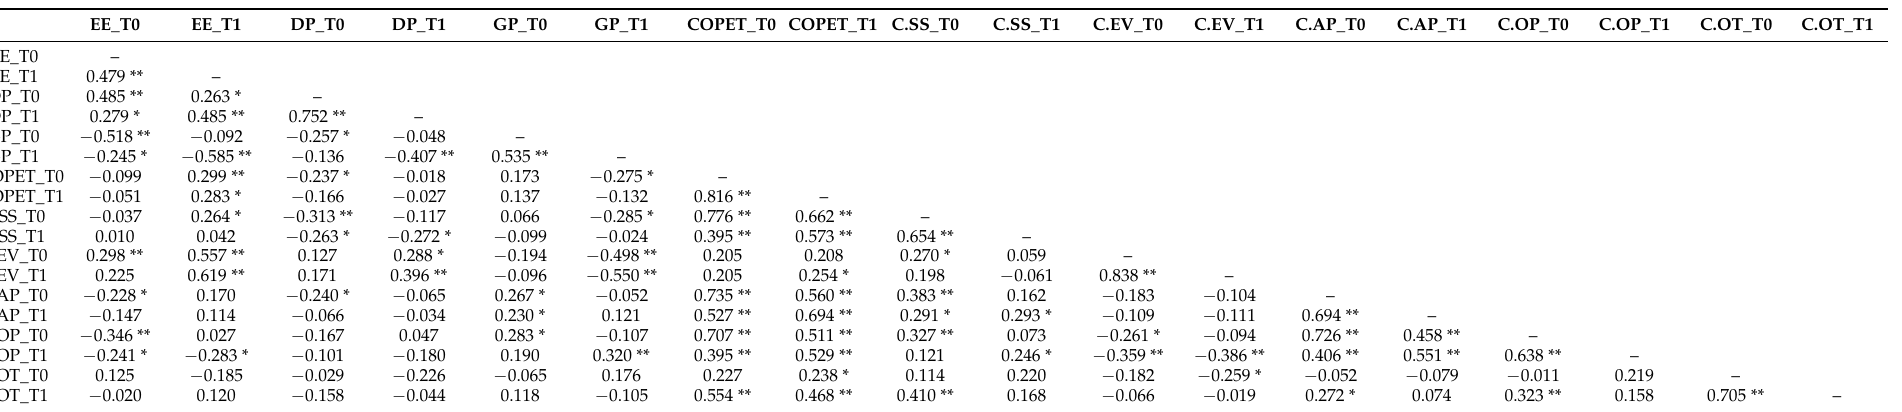
Table A4. Association between Maslach Burnout Inventory and Coping Orientation to Problems